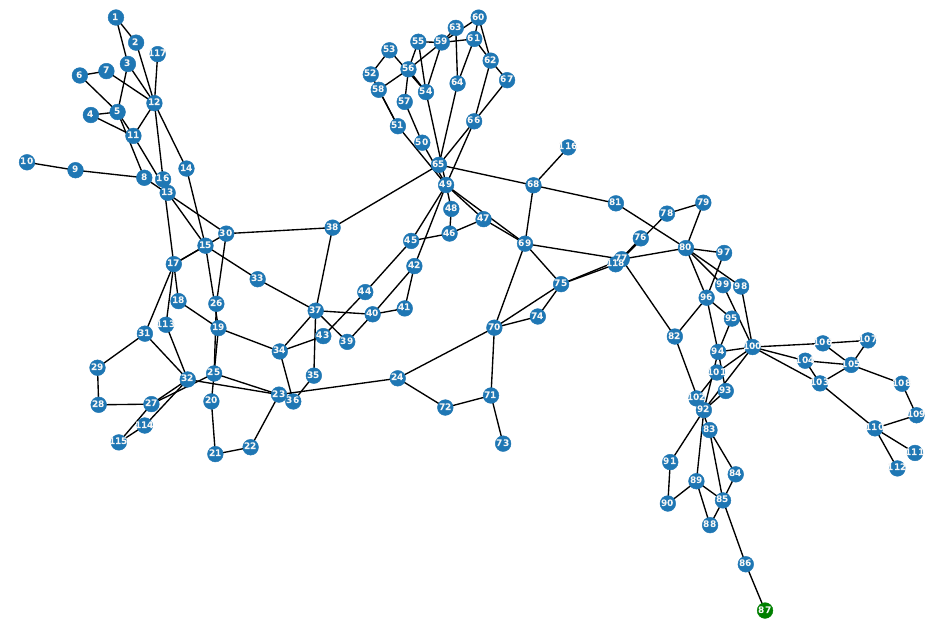
Figure 8. The 1 × 150 MW demand location during seasons 1, 2, and 3 without mobile MSSSC. Green node indicates the load connection